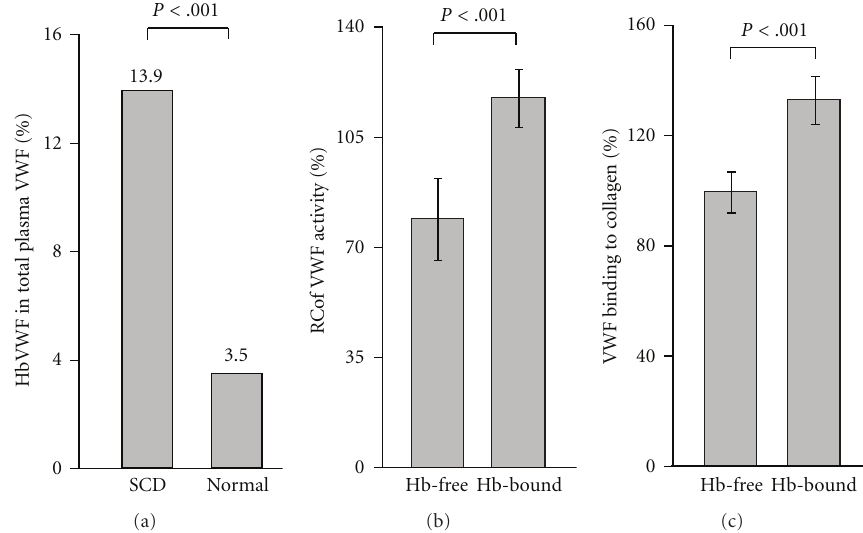
Figure 1: Hb-bound VWF multimers are prevalent in SCD patients and are hyperactive. (a): the VWF was purified from plasma (1mL) of SCD patients or normal individuals by a Superose gel filtration column. The 1st protein peak (at 280nm UV) was collected for VWF. Further, the Hb-bound VWF was isolated from above VWF fraction using an Ni-NTA a ffi nity column. The VWF antigen level was measured using a commercial kit. The Hb VWF multimers existed as about 14% of total VWF in patients compared to only about 3.5% in normals ( n = 5). (b): the ristocetin cofactor VWF activity assay shows that the Hb-bound VWF multimers are 35% more activity than the Hb-free counterparts. (c), The collagen binding assay also shows that the Hb-bound VWF multimers are 33% more adhesive to collagen than the Hb-free multimers.